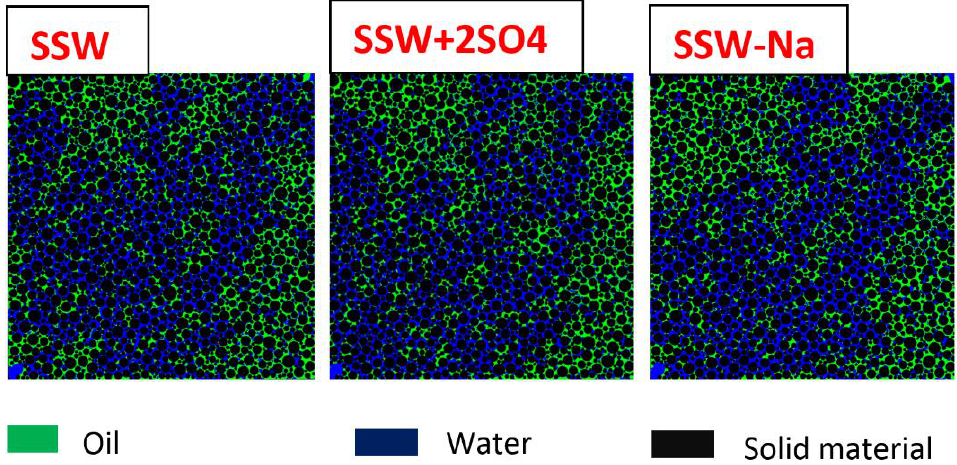
Figure 13. Artificial structure complex-wet micromodels used for three injection brines mentioned in Table 2. Figure represents the oil recovery after 10PV injected brine.